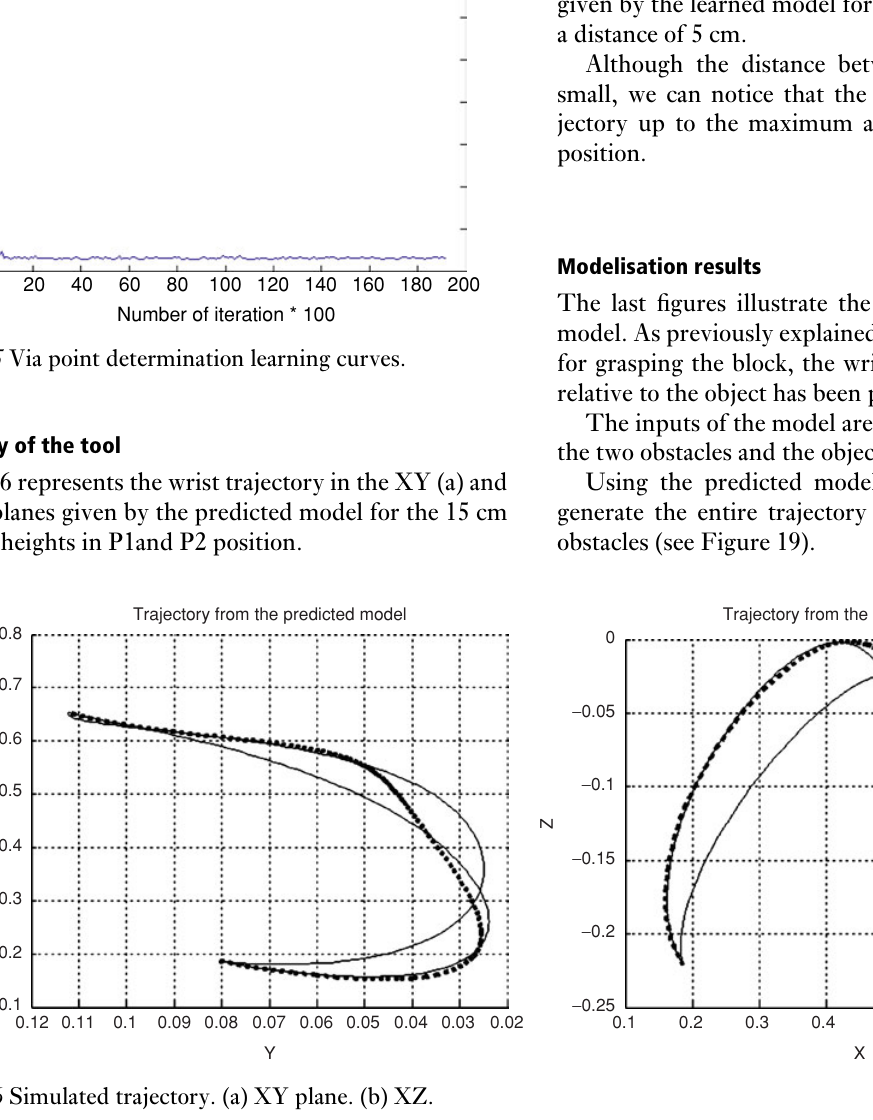
Figure 17 represents the wrist trajectory in the XZ plane given by the prediction for the 15 and 20 cm obstacle heights in P1 and P2 position. Figure 18 represents the wrist trajectory in the XZ plane